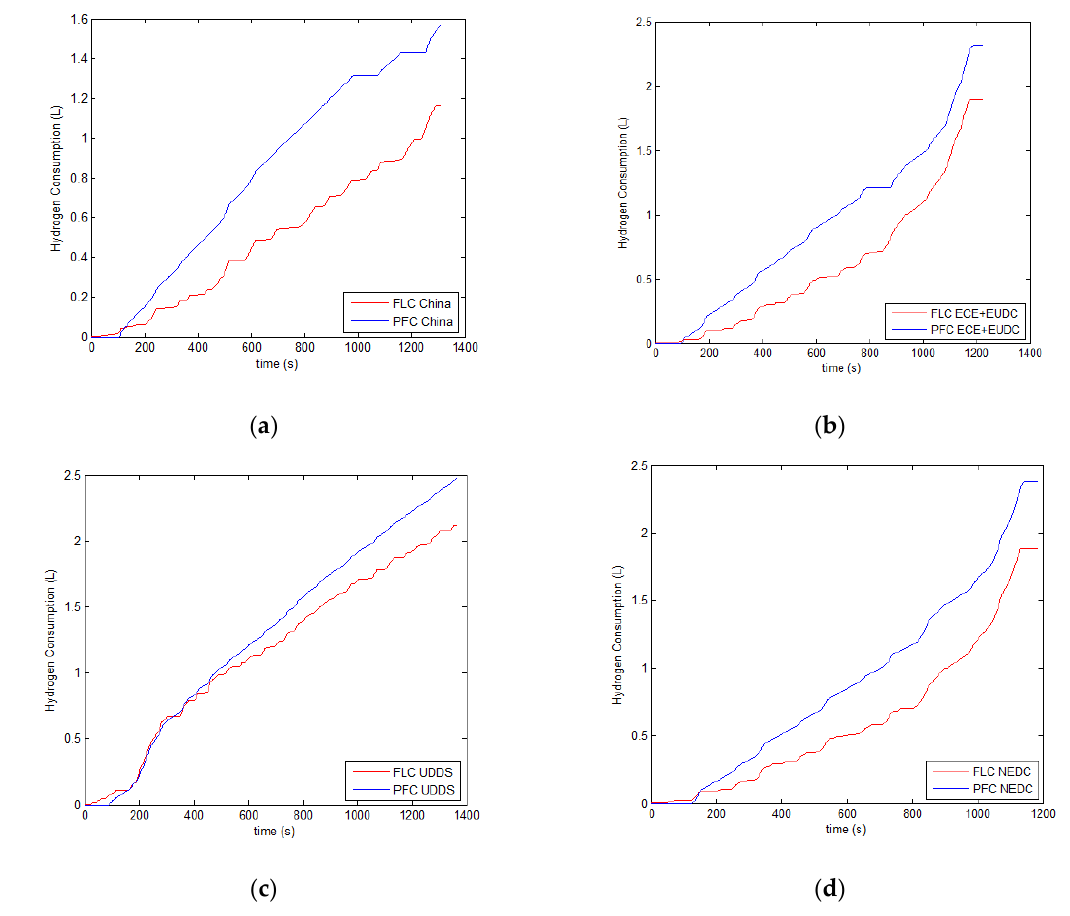
Figure 8. Comparisons of hydrogen consumption: ( a ) China, ( b ) ECE+EUDC, ( c ) UDDS, and ( d ) NEDC.